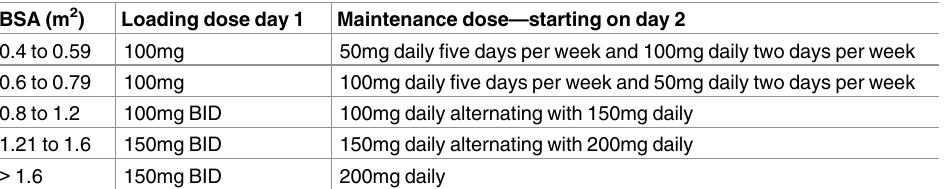
Table 5. Perifosine dose level 5 (~125 mg/m 2 /day).